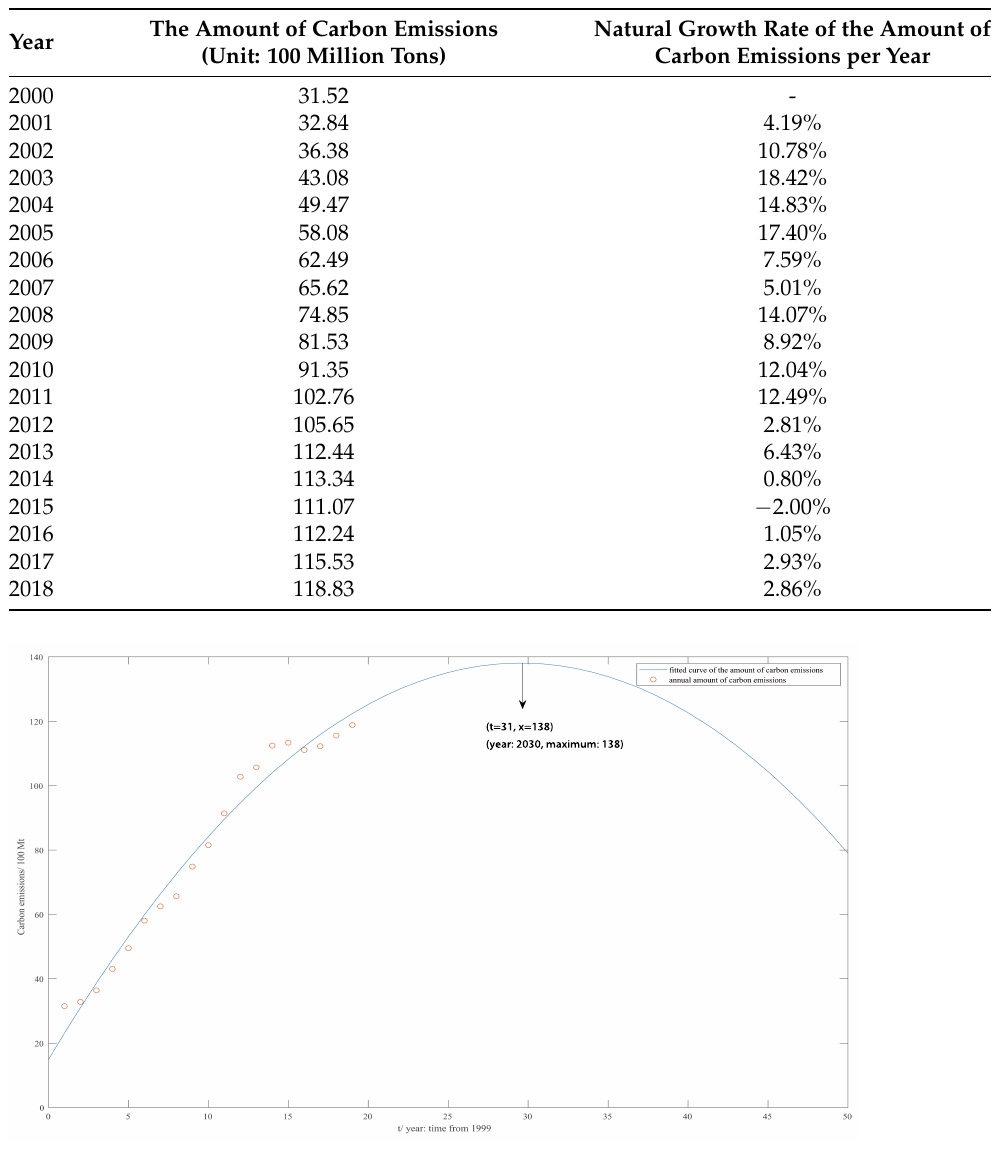
Figure 1. The amount of carbon emissions and fitting curve for China from 2000 to